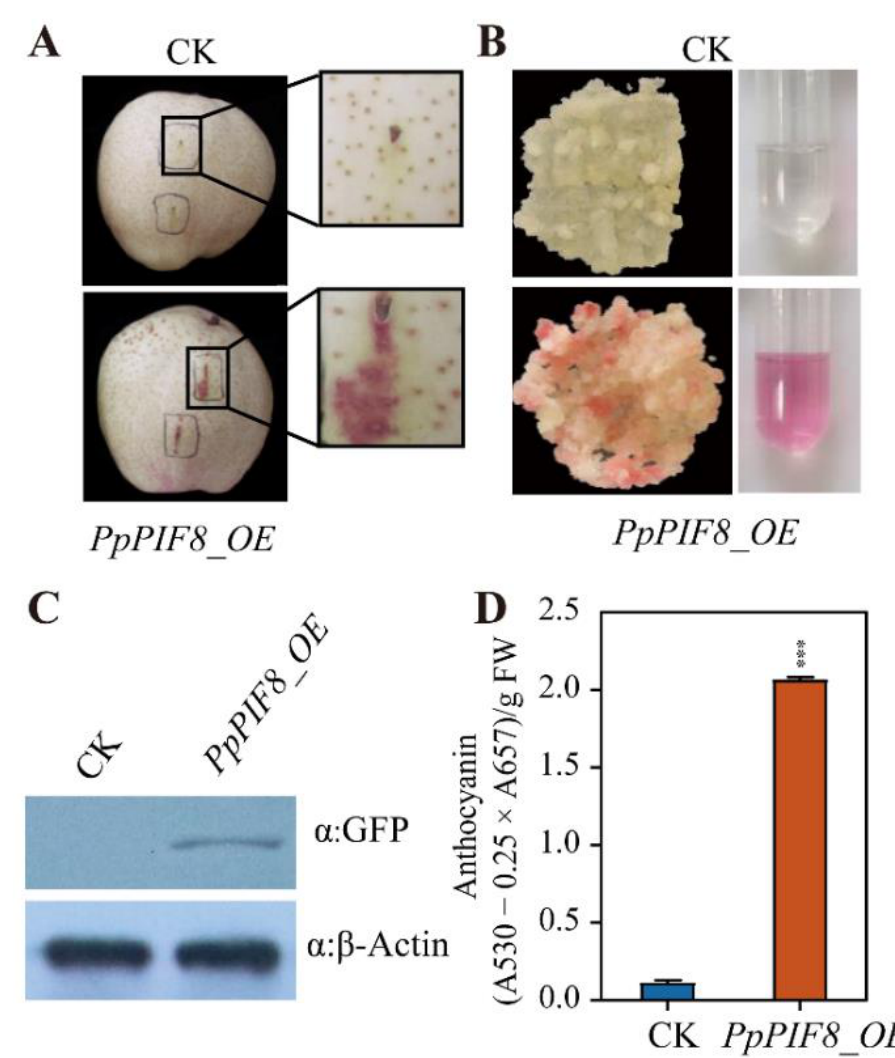
Figure 10. Overexpression of PpPIF8 promotes anthocyanin accumulation. ( A ) Transiently overex- pression of PpPIF8 in the peel of ‘Red Zaosu’ pear; empty vector was used as the negative control. ( B ) Overexpression of PpPIF8 promotes anthocyanin accumulation in pear calli. ( C ) Conformation of PpPIF8 overexpression by immunoblotting; β -actin was used as an internal reference. ( D ) Determina- tion of anthocyanin contents in ( B ). Error bars denote the standard deviations. Asterisks above the bars indicate significant differences (*** p < 0.001) obtained by two-tailed Student’s t -test. Furthermore, the KEGG enrichment analysis was conducted for DEGs. For the Pp- PIF8 upregulated genes, the terms significantly enriched were: Flavonoid biosynthesis, Secondary metabolites biosynthesis, Plant hormone signal transduction, Photosynthesis proteins. However, for the PpPIF8 downregulated genes, the terms significantly enriched were: MAPK pathway, Transcription factor, Signal transduction, Plant–pathogen interaction (Figure 11D). Together, these data suggest that PpPIF8 promotes anthocyanin biosynthesis mainly by activating gene expression, such as PpCHS , PpMYB10 , and PpMYB12